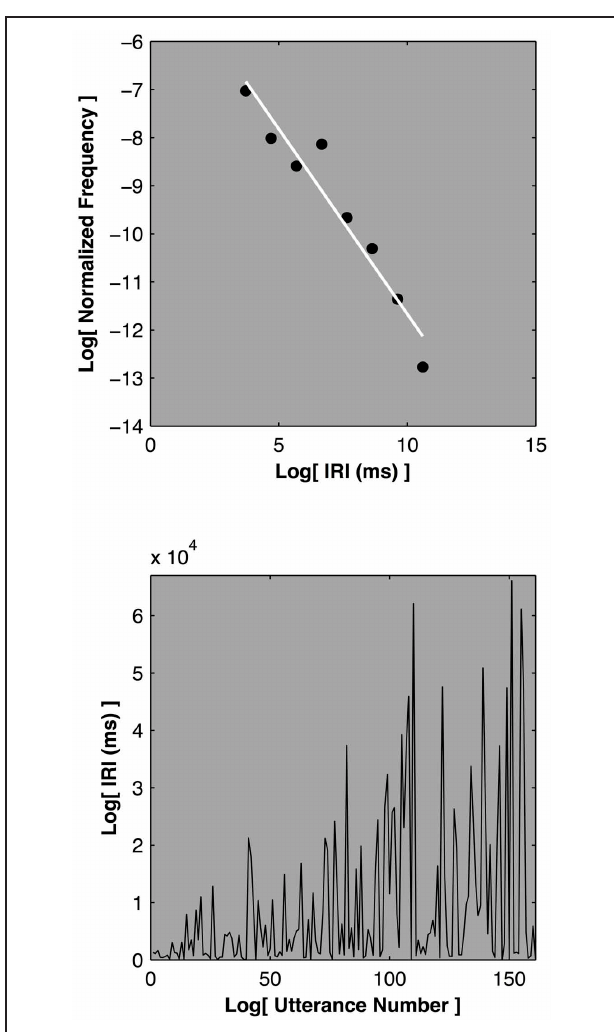
FIGURE 6 | Depicts the outcome of a free-recall semantic memory session for a single participant from Nash (2012). The upper plot displays the normalized frequency as a function of the inter-recall interval on log-log axes. The relationship is approximately linear, indicating a power law. The lower plot displays the inter-recall-intervals as a function of the utterance number, the raw data used to generate the